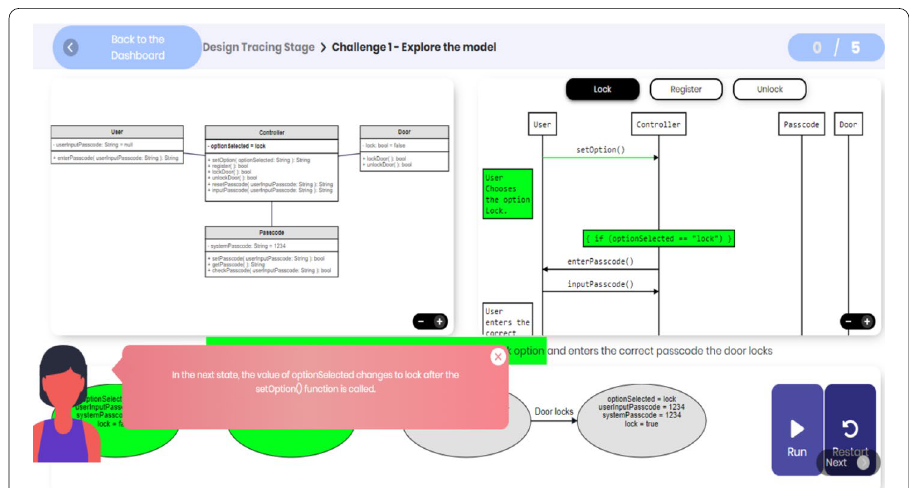
Fig. 5 The agent explaining the state diagram execution for Challenge